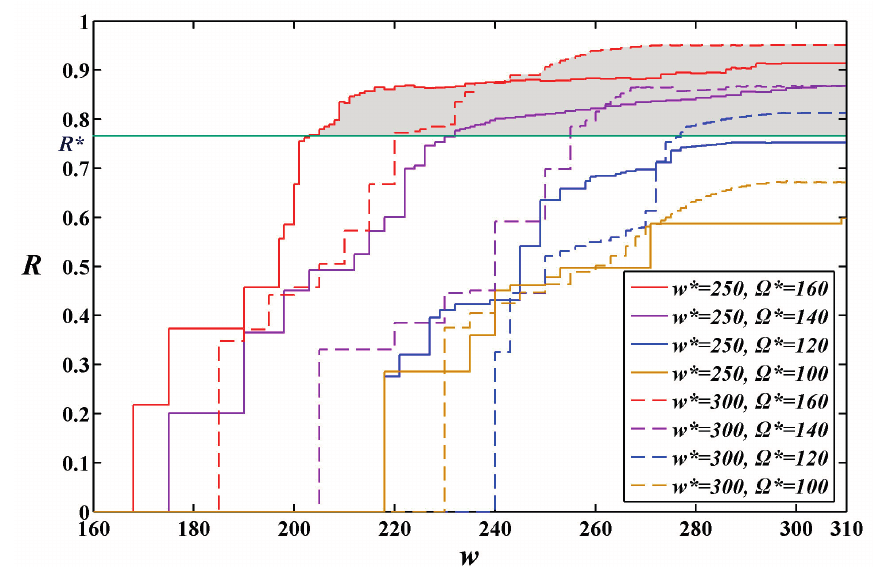
Figure 11. The values of reliability function R ( w * ) with changes in the execution time w from 160 to 310 under the given cost constraint on Ω * with changes from 100 to 160 and on the two given expected execution times ( w * = 250 and w * =